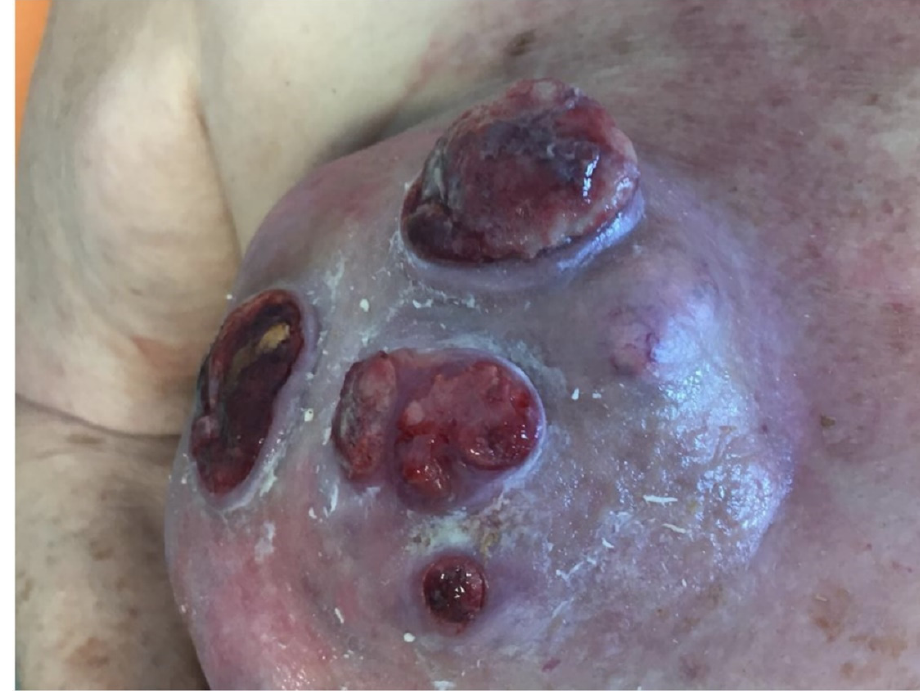
Figure 3. After seven days.